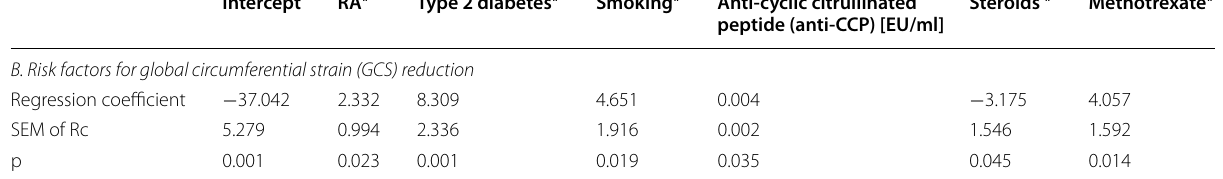
# Dichotomous variable, where 1- no, 2- yes